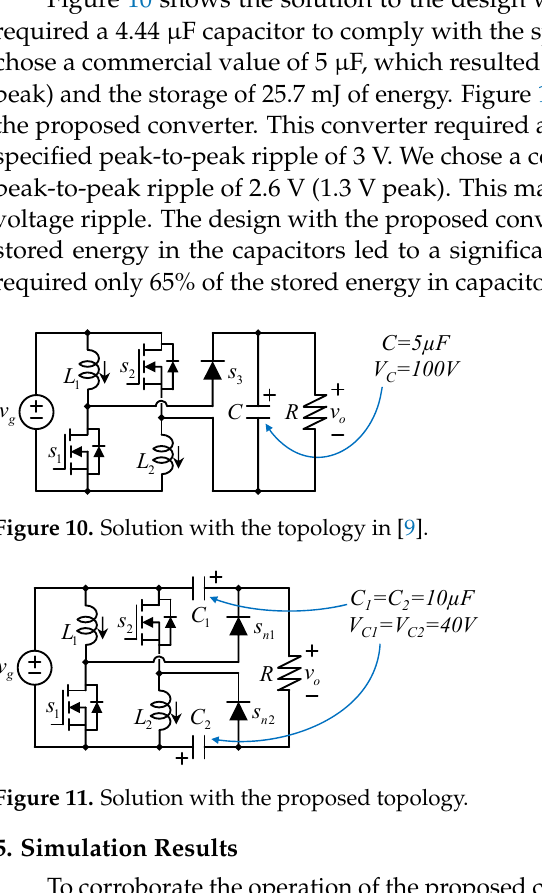
Figure 12. Schematic of the simulated converter. Table 2. Parameters. Inductor L 1 and L 1